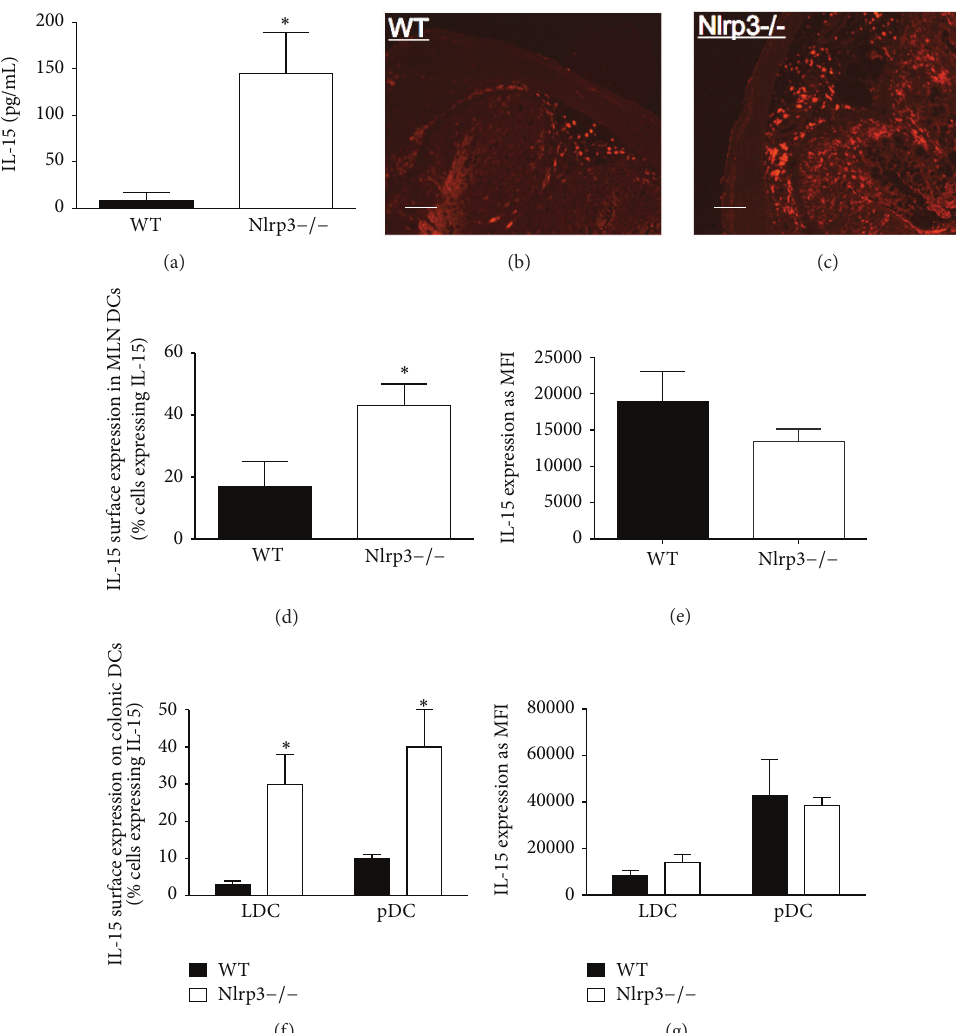
Figure 3: Nlrp3 − / − mice exhibit increased numbers of IL-15 expressing DCs in the MLN and colonic following a 7-day course of DSS. (a) The quantification of IL-15 in colonic tissue isolated from WT and Nlrp3 − / − on day 7 of DSS. ∗ denote 𝑝 < 0.05 compared to WT; 𝑛 = 5 /group. Representative images of (b) WT and (c) Nlrp3 − / − colonic sections stained for IL-15; scale bar = 100 microns. Flow cytometric analysis of IL-15 expression on the surface of all DCs isolated from the MLNs of WT and Nlrp3 − / − on day 7 of DSS, expressed as a percentage of IL-15 expressing cells (d) and mean fluorescence intensity (MFI) per cell (e); ∗ denotes 𝑝 < 0.05 compared to WT; 𝑛 = 6 /group. Flow cytometric analysis of IL-15 expression on the surface of lymphoid (CD11c+/CD8+; LDC) and plasmacytoid (CD11b+/B220+/CD11c − ; pDC) DCs isolated from the LP of WT and Nlrp3 − / − mice on day 7 of DSS, expressed as a percentage of IL-15 expressing cells (f) and MFI per cell (g); ∗ denotes 𝑝 < 0.05 compared to WT; 𝑛 = 5